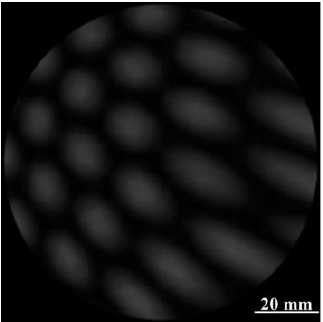
Figure 8. Raw interferogram at a wavelength of 633 nm.